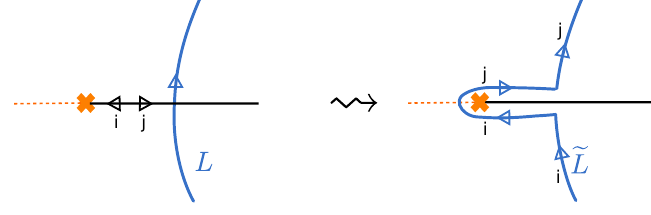
Figure 15 . A detour lift of a segment of L which crosses a critical leaf.